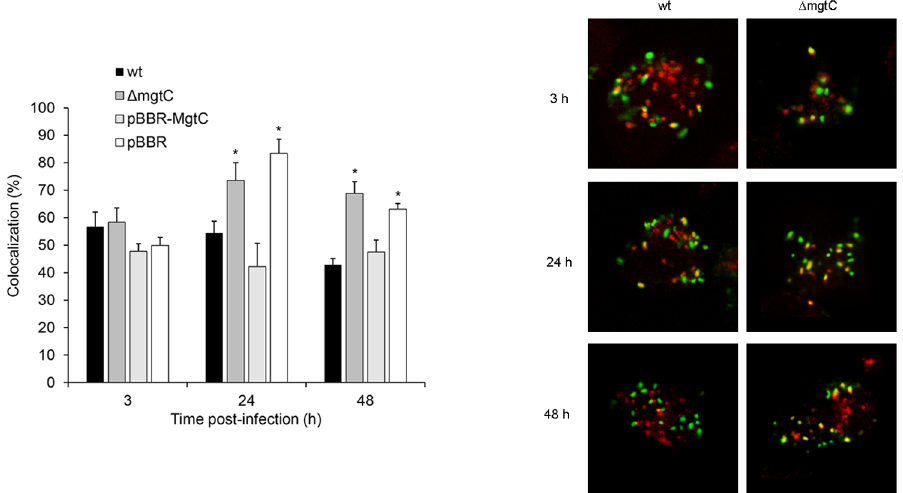
Fig 3. Time course of B . pertussis colocalization with the acidotropic dye LysoTracker. Wild type B . pertussis (wt), B . pertussismgtC deficient mutant ( Δ mgtC ), B . pertussismgtC deficient mutant carrying the pBBR1MCS vector (pBBR), and B . pertussismgtC deficient mutant carrying a pBBR1MCS derivative that encodes mgtC (pBBR- mgtC )were incubated with THP-1 cells (MOI: 100) for 2 h at 37˚C. After being washed, the macrophages were incubated with polymyxin B (100 μ g/mL) prior incubation with LysoTracker (3 h), or further incubated with RPMI-FBS-polymyxin B (5 μ g/mL) for other 24 and 48 h before treatment with the acidotropic dye LysoTracker (red). Intracellular bacteria were green fluorescently labelled prior to confocal microscopy analysis. Colocalization of bacteria and LysoTracker is refected by yellow areas. The bars indicate the percentage of LysoTracker-positive phagosomes. The means ± SD of triplicates of one representative experiment out of two performed are given. The percentage of Δ mgtC and pBBR colocalizing with LysoTracker at 24 h and 48 h post-infection was significantly different from the number of wt and pBBR- mgtC bacteria colocalizing with LysoTracker at the respective time points. Statistical significance analysis was performed using one-way ANOVA ( (cid:3) P < 0.05). Confocal microscopy images of a representative experiment are